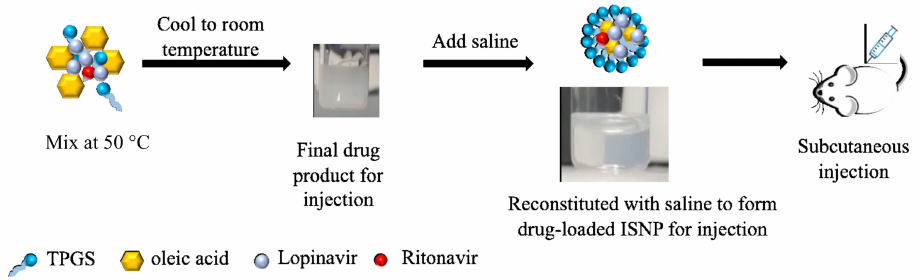
Figure 1. Illustration of manufacturing the ISNP-based LPV/RTV injection and the formation of LPV/RTV-loaded